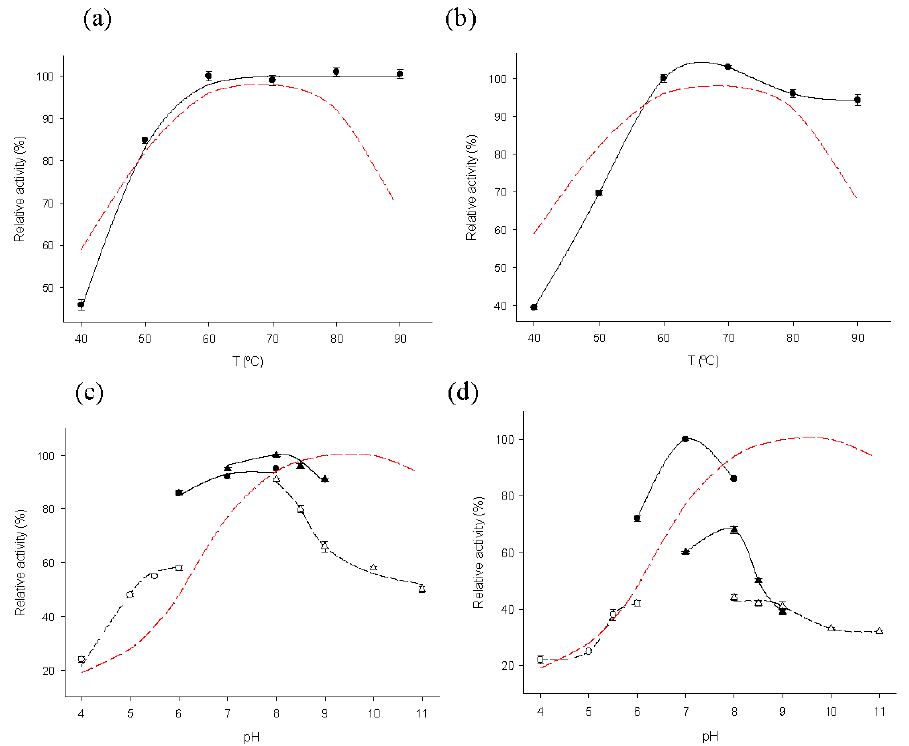
Figure 2. Temperature and pH dependence on the activity of M Tt HGXPRT derivatives. ( a ) Effect of